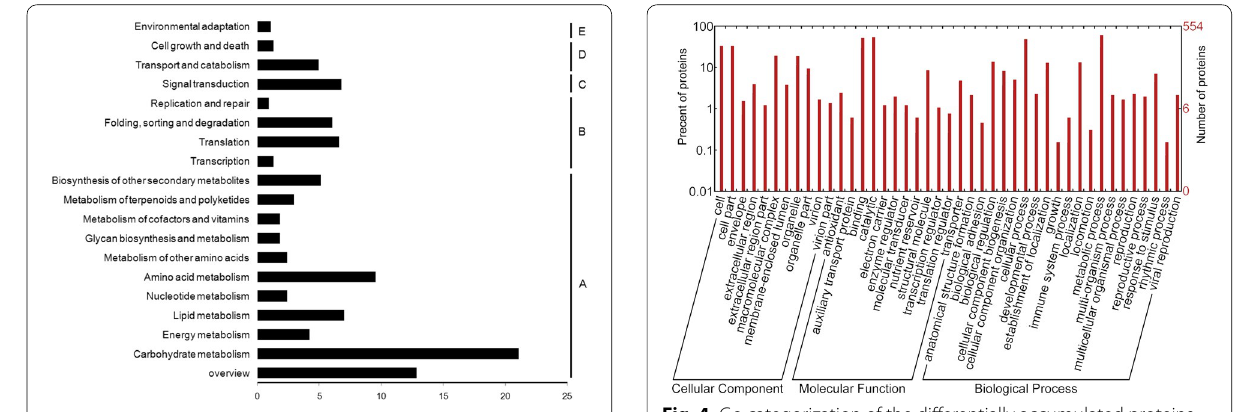
Fig. 4 Go categorization of the differentially accumulated